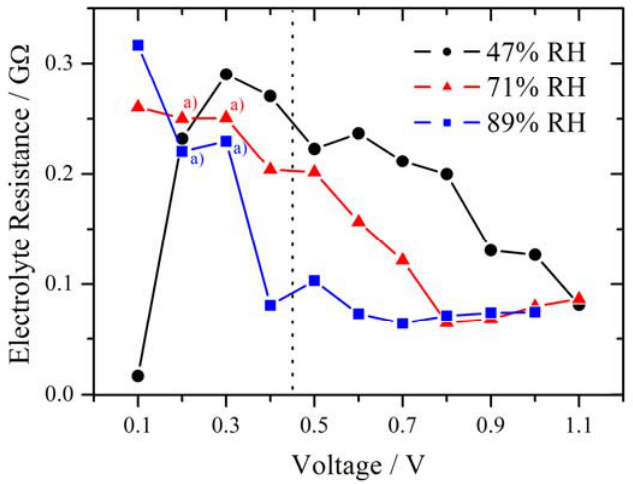
Figure 9. Simulated electrolyte resistance plotted for different relative humidities as a function of the voltage step. The dotted line marks the change from the RC-circuit (left side) to the modified Randles circuit (right side) used for the simulation. With increasing RH the electrolyte resistance decreases. a) indicates R values which were fixed during the el simulation of the impedance spectra.